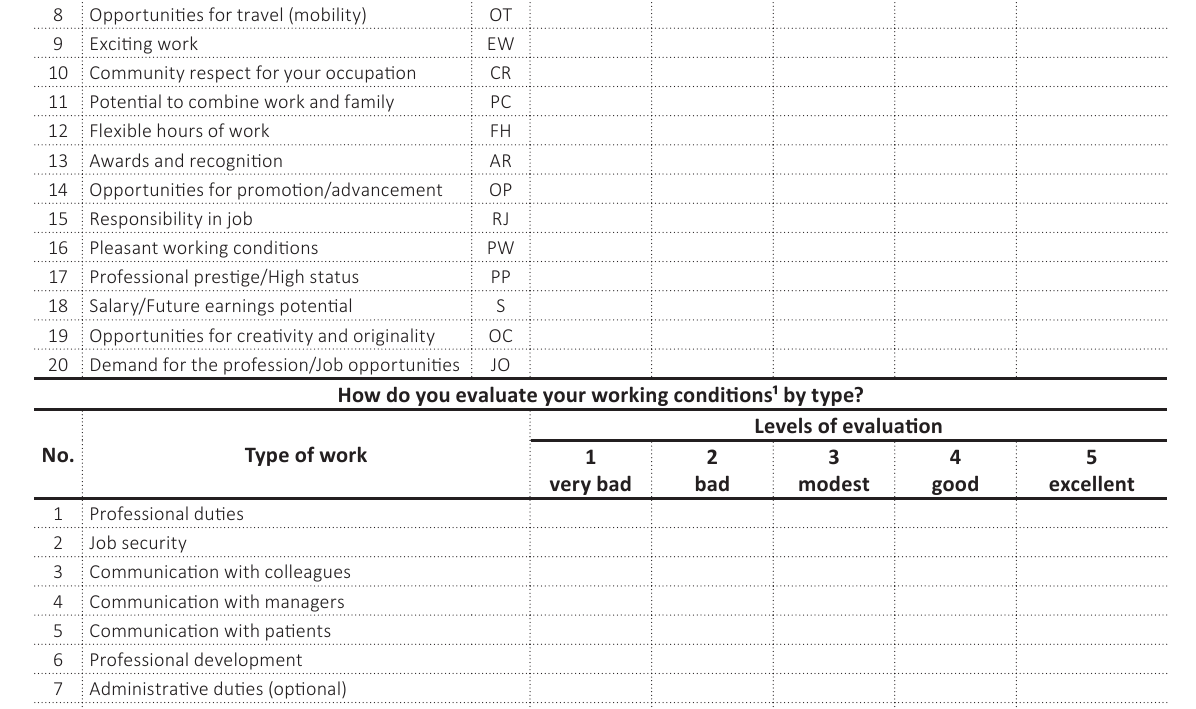
Table A1. Medical staff questionnaire on motivation and working conditions